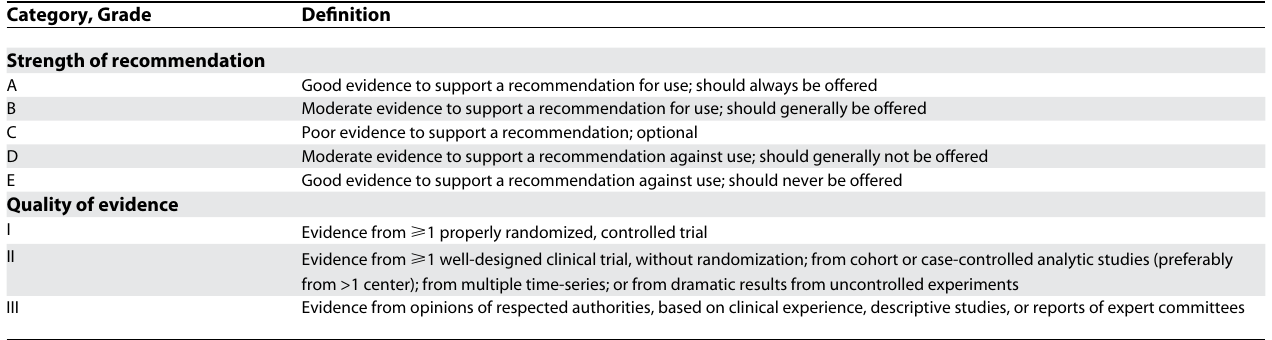
Table 1. Infectious Diseases Society of America United States Public Health Service Grading System for Ranking Recommendations